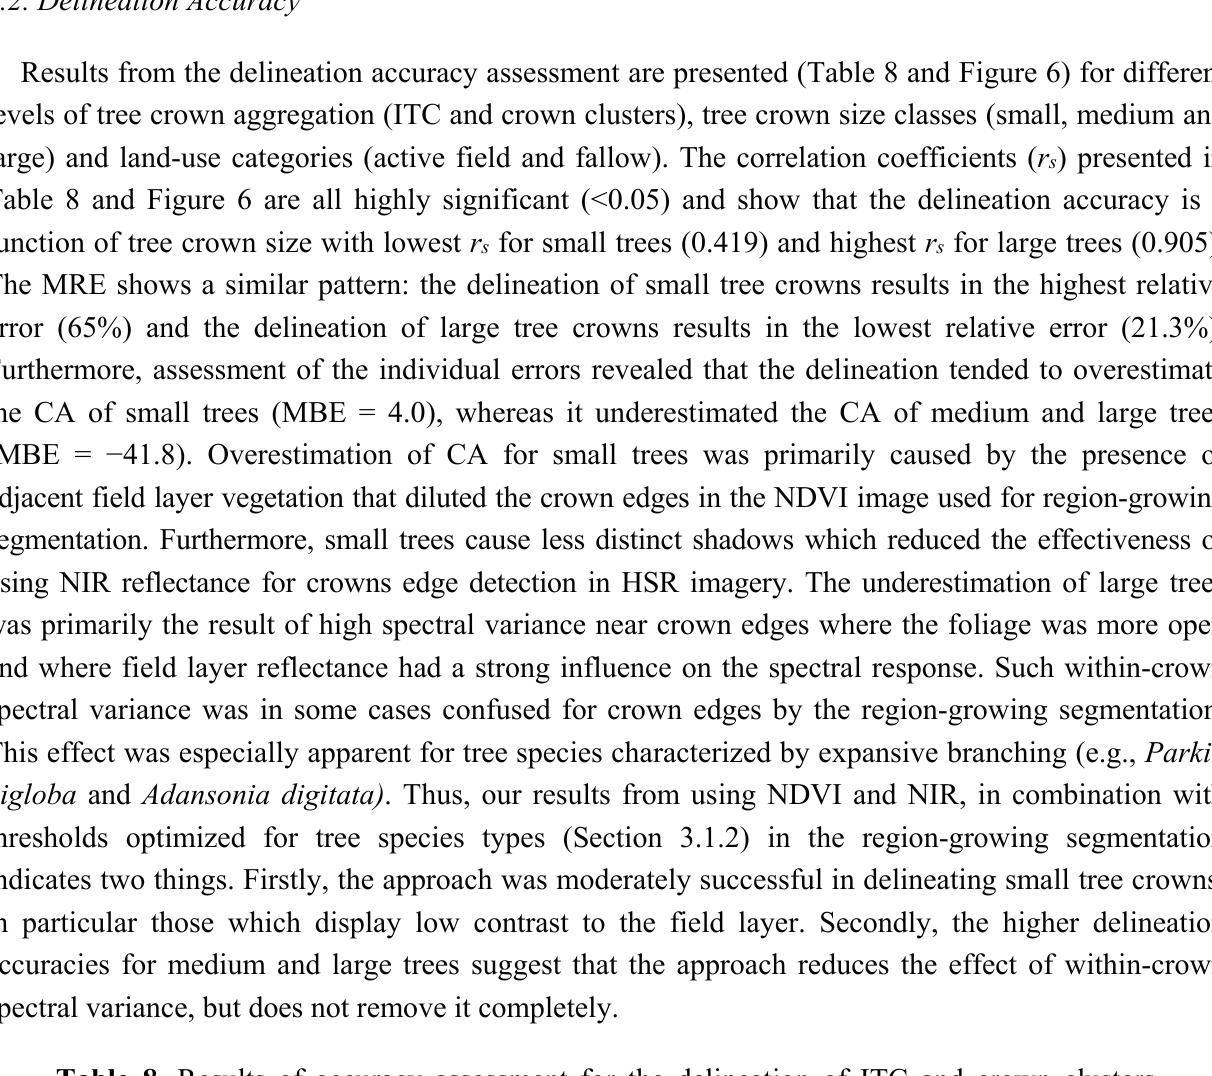
Table 8. Results of accuracy assessment for the delineation of ITC and crown clusters presented by Spearman’s Rho correlation coefficient ( r s ), mean absolute error (MAE), mean relative error (MRE), and mean bias error